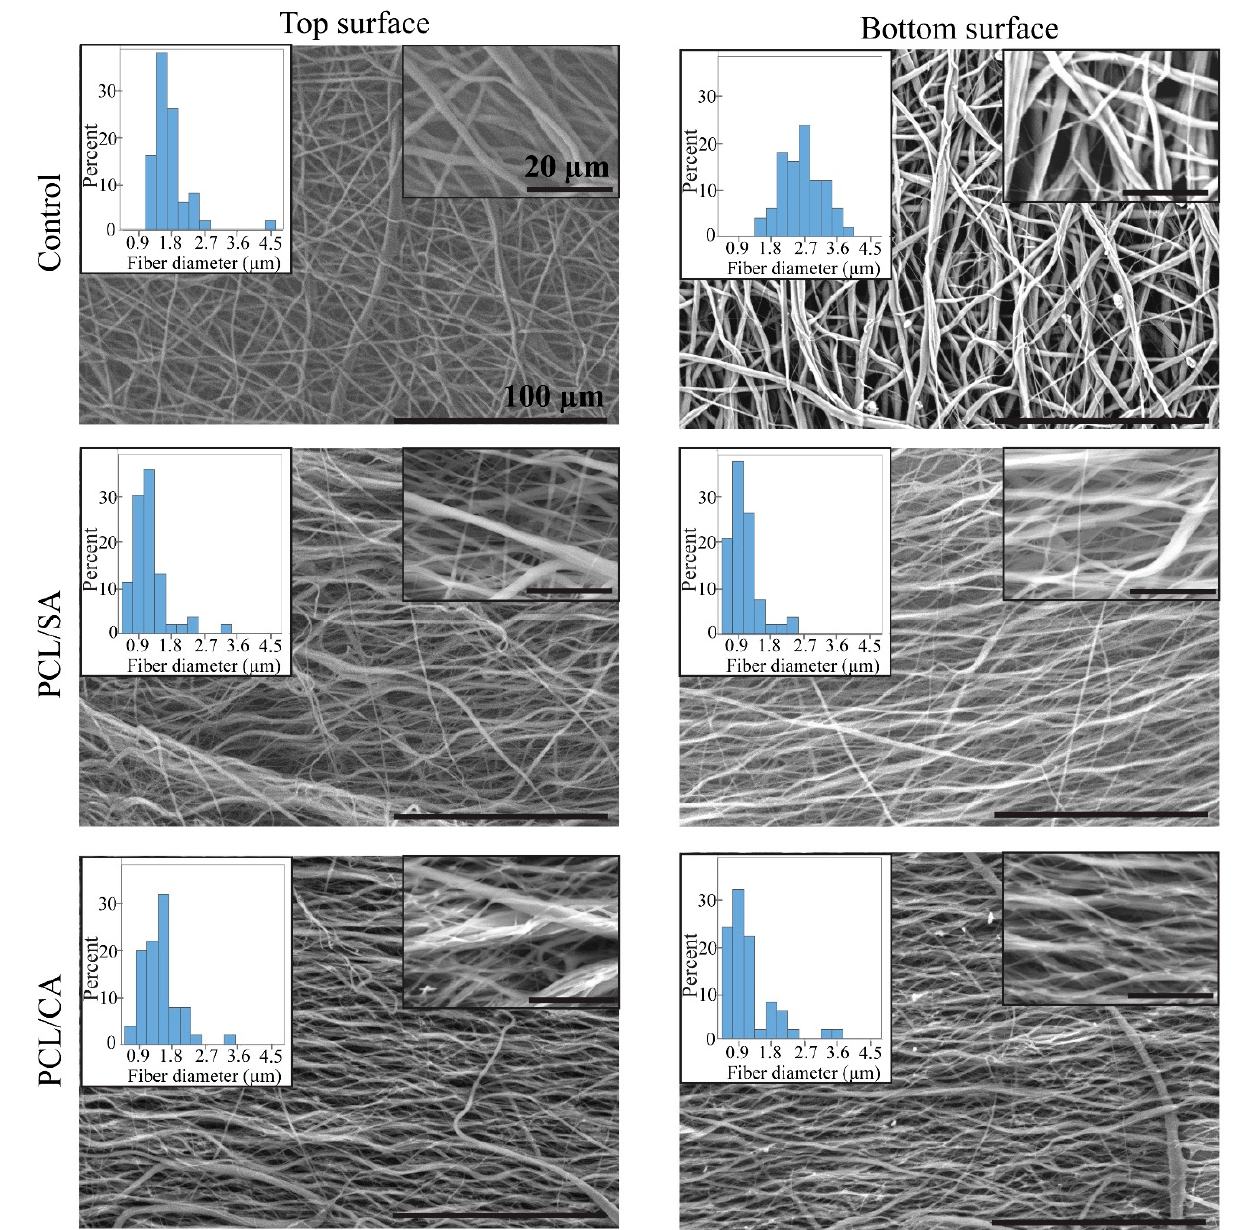
Figure 2. SEM images showing the morphology of the top and bottom surfaces of control, PCL/SA, and PCL/CA scaffolds. The scale bars in all insets on the right and main images are equal to 20 and 100 µm, respectively. The insets on the left show the fiber diameter histogram of each scaffold.